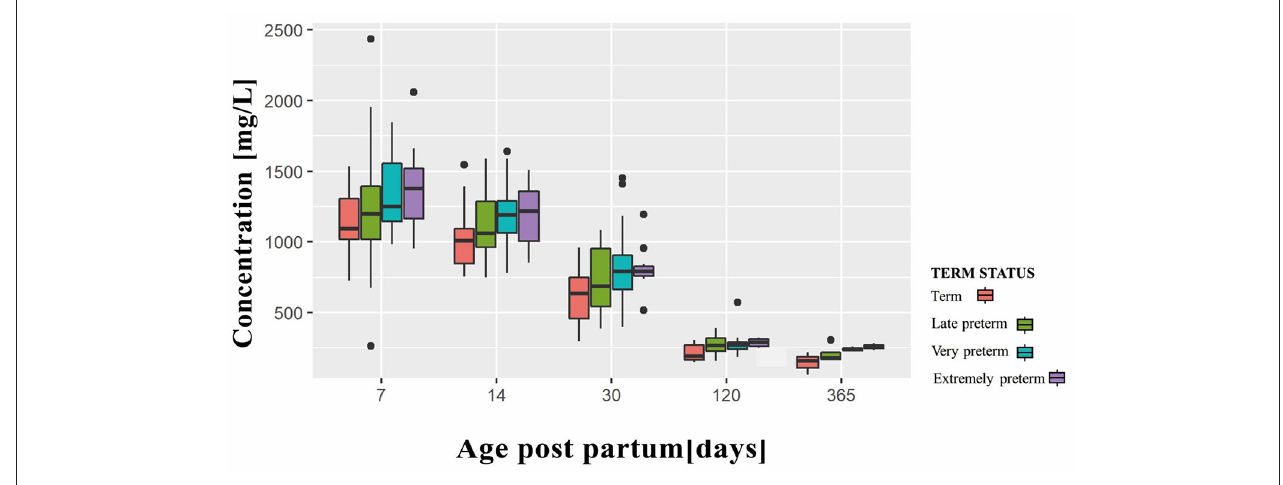
FIGURE 2 | Variation trend of sialic acid over